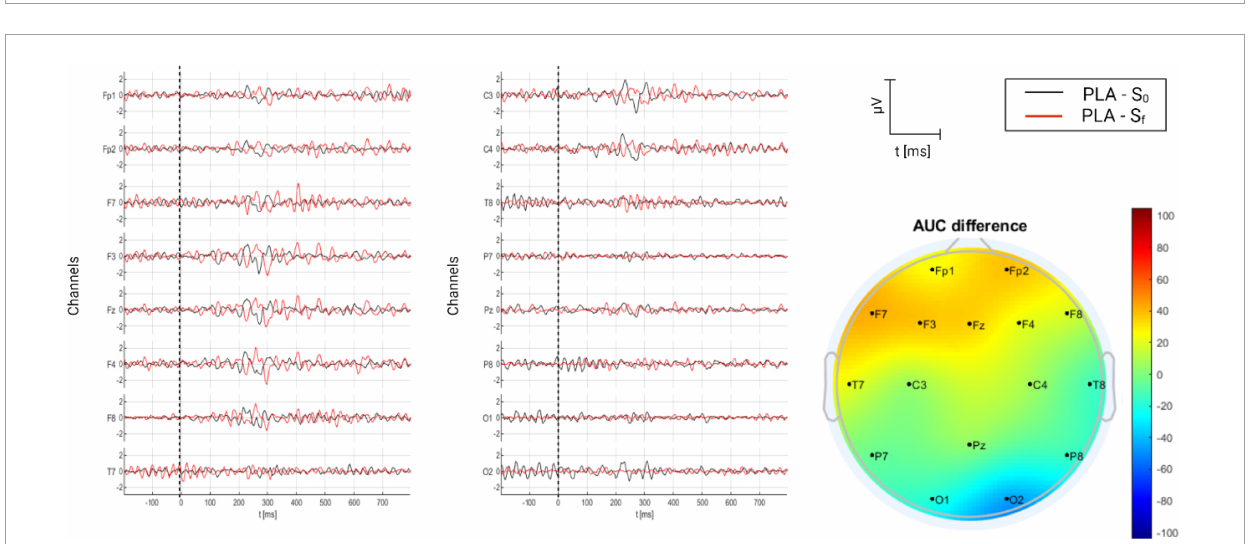
FIGURE8 Grand average of AERPs at S 0 (initial session) and S f (final session) for placebo group (tinnitus sufferers treated with relaxing music). In addition, the AUC difference of these two grand averages (S f – S 0 ) is topographically plotted in µ